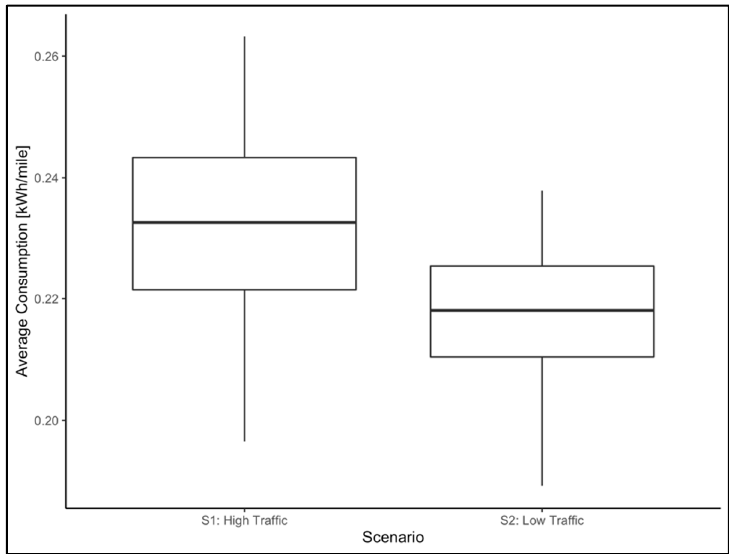
Figure 2. Boxplots of average energy consumption per mile for the respective scenario.